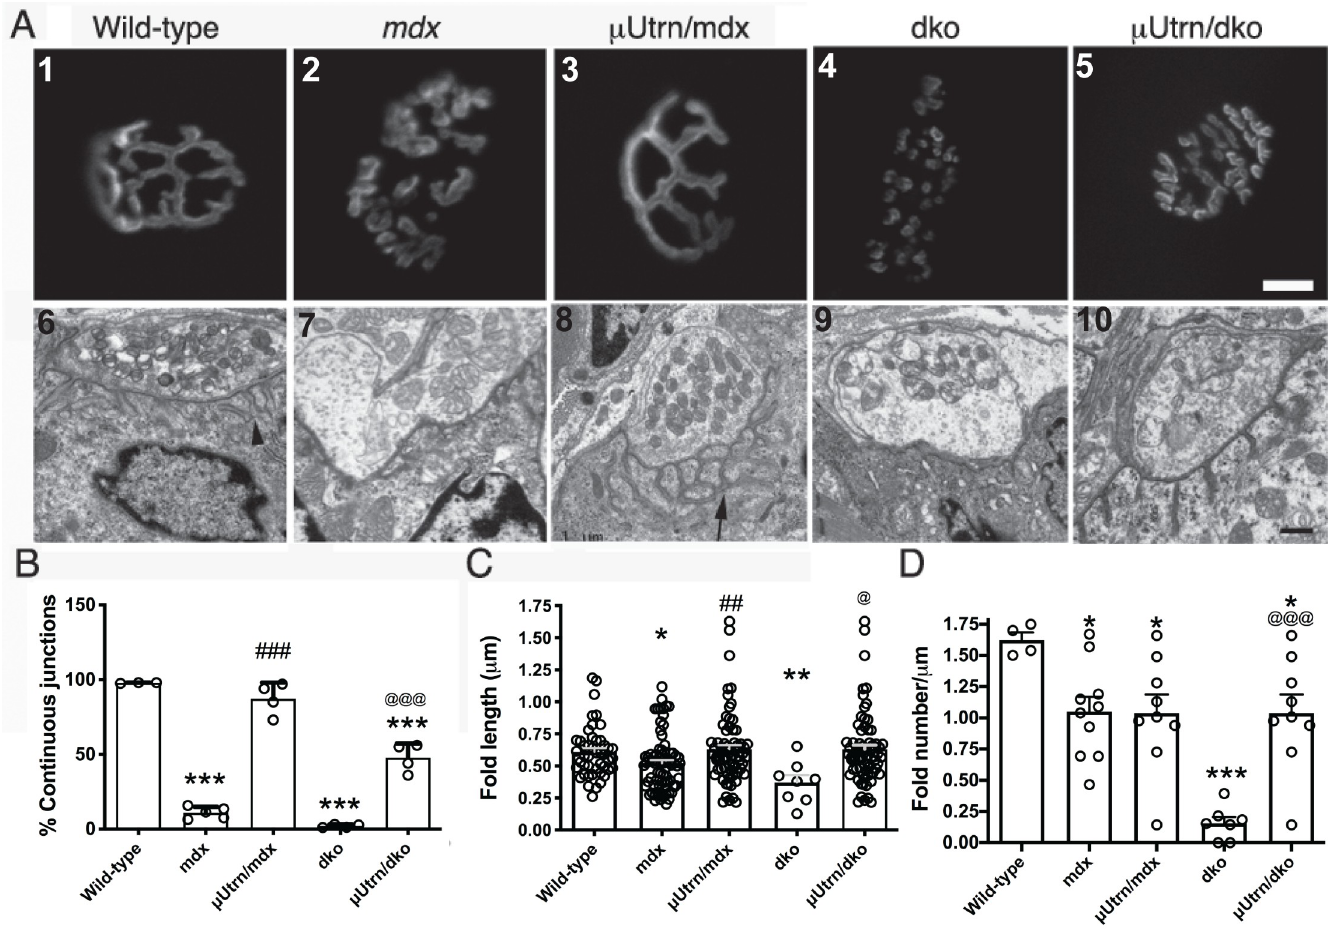
Fig 6. μ Utrn expression partially restores the structure of neuromuscular junctions. (A) Top panel: AChR cluster visualization in the postsynaptic apparatus reveals that μ Utrn expression prevents the fragmentation of synapses seen in mdx 4cv and dko muscles. Scale bar = 10 μ m. Lower panel: Electron microscopic images of neuromuscular synapses reveals that the synaptic folds in wild-type mice (arrow head) are shallower and less in number in muscles from mdx 4cv mice and dko mice. μ Utrn restores the depth, but not the number of synaptic folds. However, the synaptic folds are highly branched in the mdx 4cv mice treated with rAAV- μ Utrn. Scale bar = 0.5 μ m. (B) Mean +/- S.D. of continuous synapses. (C) Mean +/- S.D. of fold lengths in the postsynaptic apparatus. (D) Mean +/- S.D. of the number of postsynaptic folds/ μ m. � P < 0.05, �� P < 0.001, and ��� P < 0.001 compared to wild-type. ## P < 0.01 and ### P < 0.001 compared to mdx 4cv . @ P < 0.05 and @@@ P < 0.001 compared to